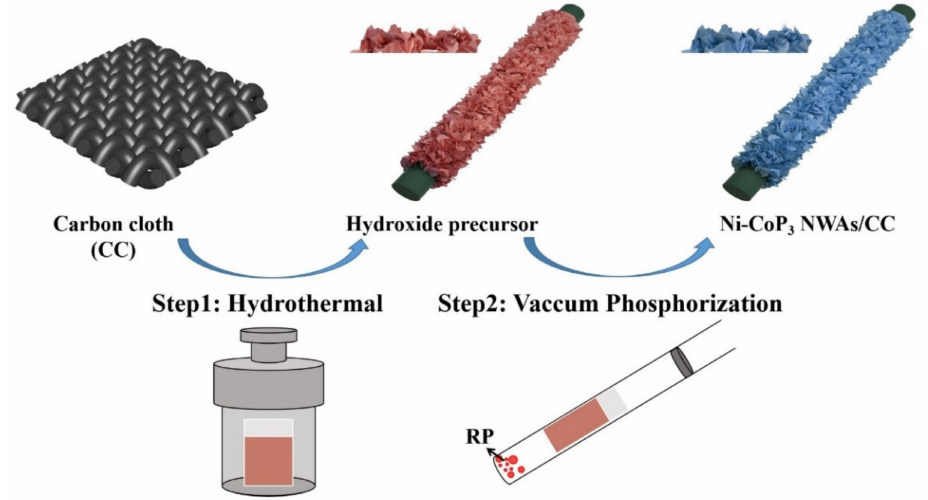
Figure 1. Schematic of synthesis procedure of Ni-doped CoP 3 nanowall